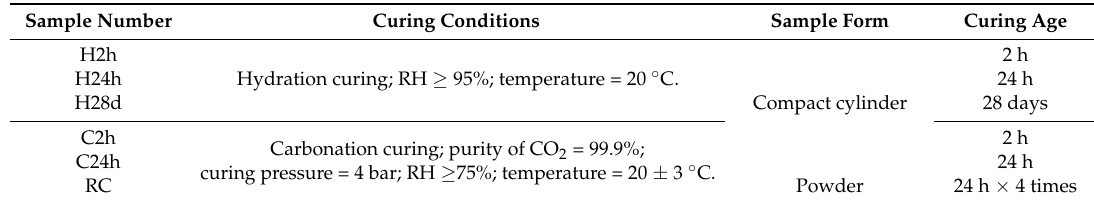
Table 2. Sample number and curing details.